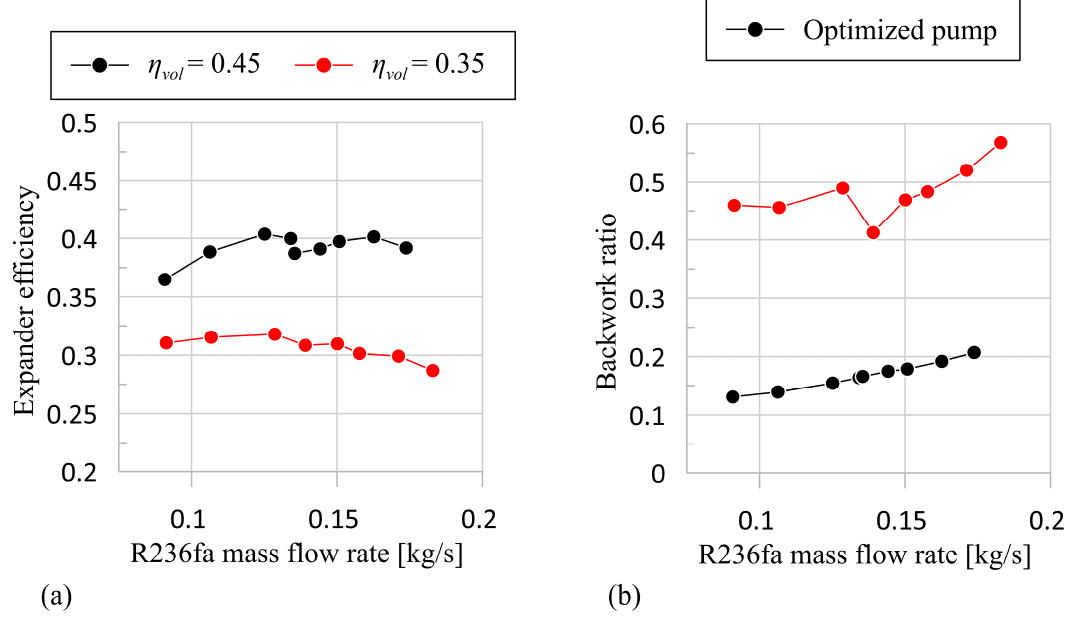
Figure 15. ( a ) Efficiency of the two expanders; and ( b ) backwork ratio of the optimized and current Figure15. ( a )E ffi ciencyofthetwoexpanders; and( b )backworkratiooftheoptimizedandcurrentpump. pump.